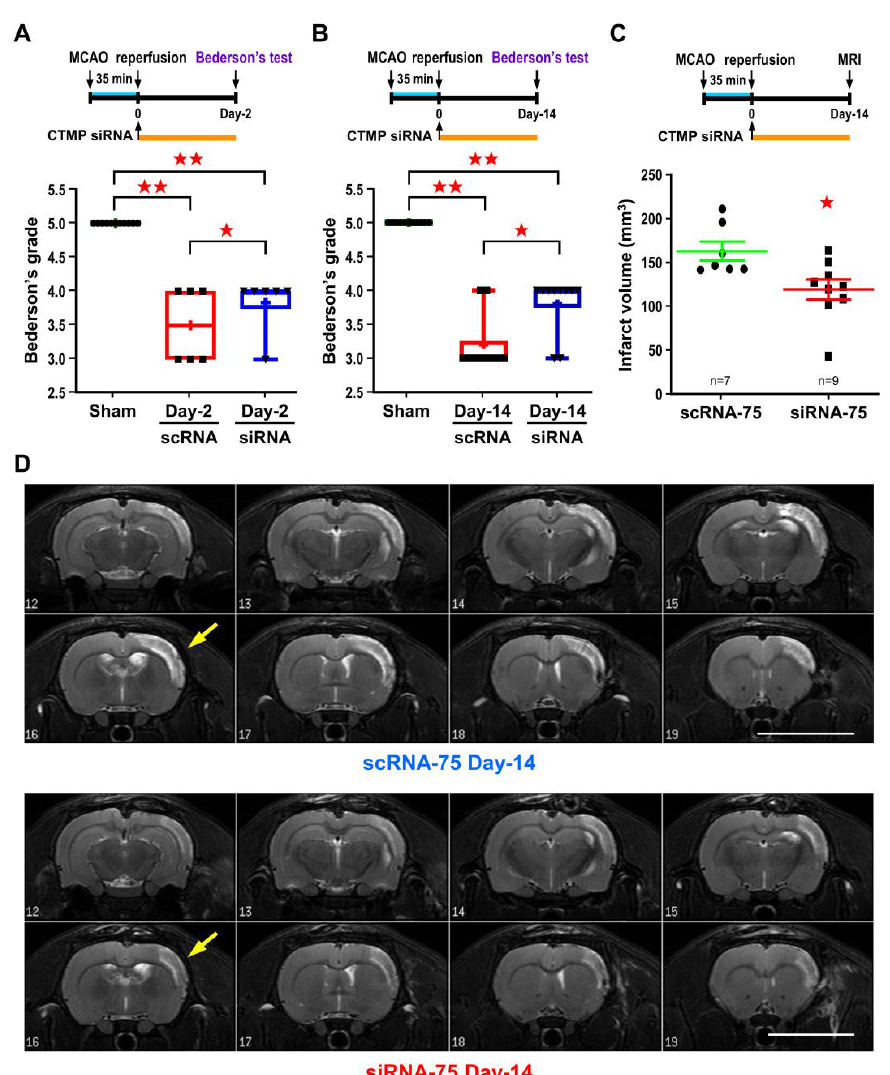
Figure 7. Post-ischemic CTMP siRNA treatment leads to sustained reduction in brain infarct and improves neurological deficit. Rats were subjected to icv infusion of 75 pmol CTMP siRNA right after 35 min of MCA occlusion. Functional outcome based on Bederson’s postural reflex test were measured at 2 and 14 days of reperfusion ( A , B ). Rats were then subjected to T2-weighted MRI for infarct volume analysis ( C ), representative T2-weighted MR images of coronal brain sections are shown in panel ( D ). Each dot represents a data point from an individual animal. Data are expressed as mean ± SD ( n ≧ 6). ★ p < 0.05 and ★★ p < 0.01 vs. controls. White area represents infarct area (yellow arrow). (Bars = 1 cm). CTMP: carboxyl-terminal modulator protein; MCAO: middle cerebral artery occlusion; scRNA: scramble RNA; siRNA: small interfering RNA.